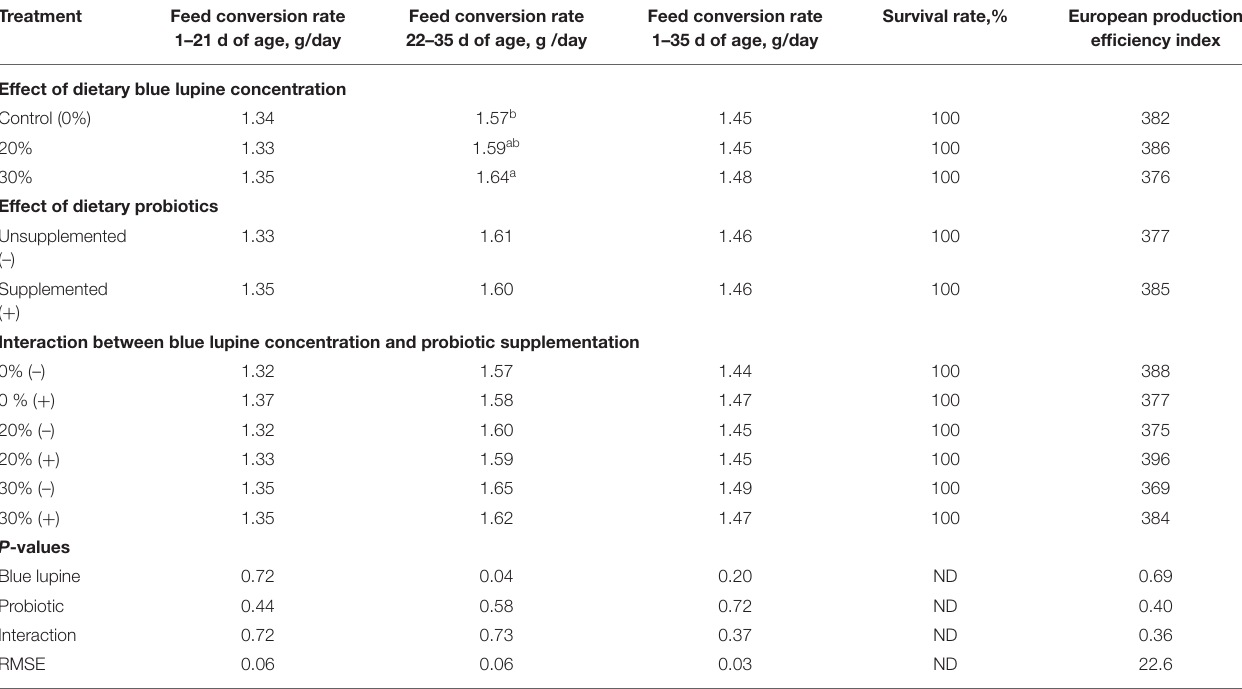
TABLE 4 | Effect of blue lupine and probiotics on feed conversion rate, European production efficiency index, and economic efficiency of broiler chickens from 1 to 35 d of age.